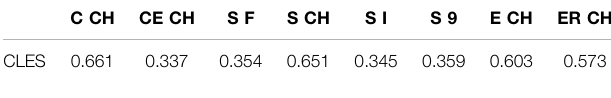
TABLE 6 | Wilcoxon common language effect